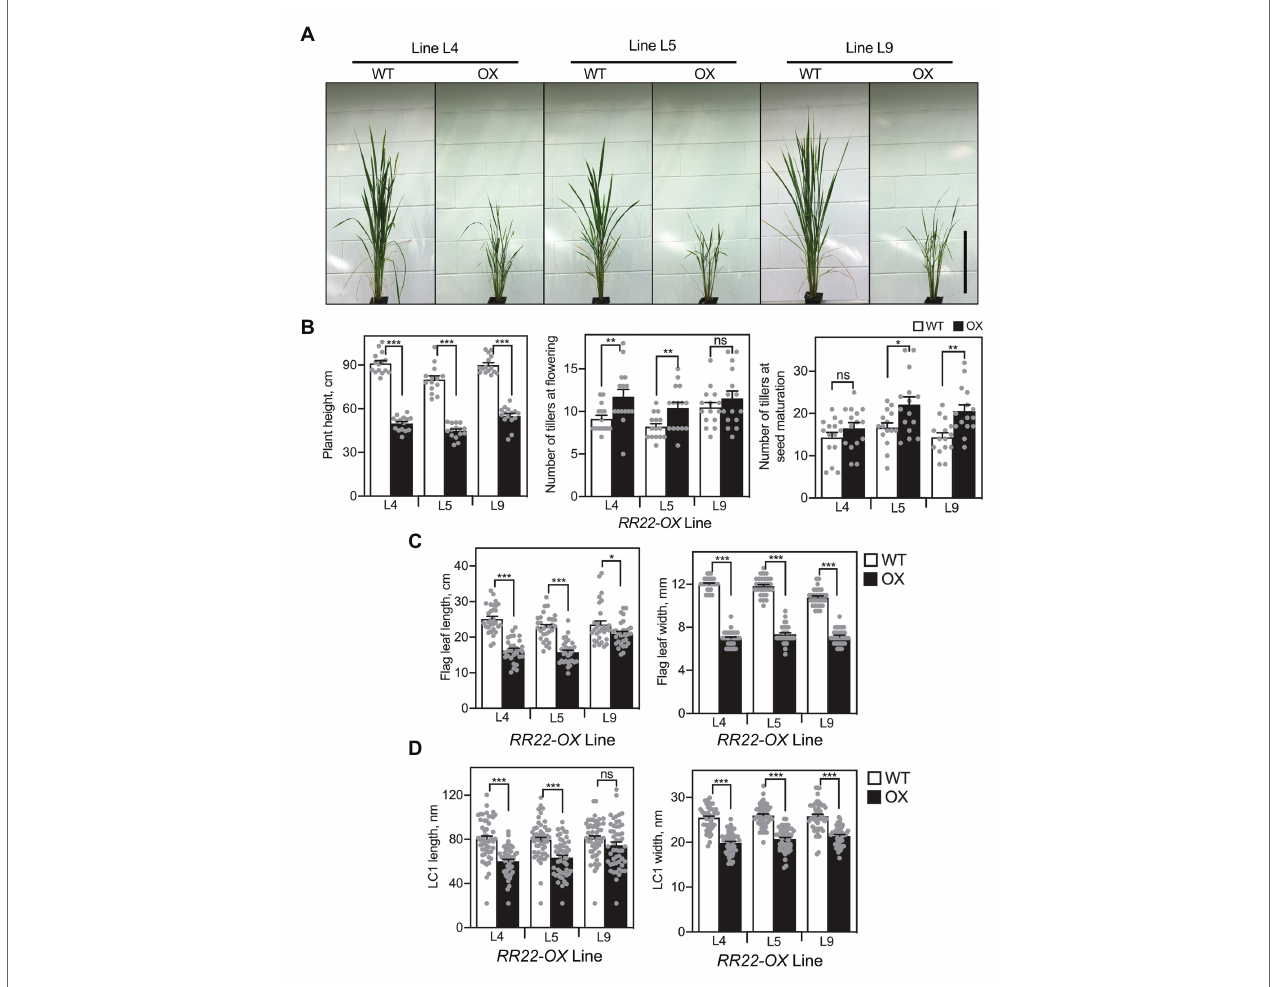
FIGURE 3 | Shoot growth phenotypes of RR22-OX lines. (A) Shoots of RR22-OX lines and their WT siblings, taken at the initiation of flowering in the WT plants. Scale bar = 30 cm. (B) Plant height at flowering, number of tillers at flowering and at seed maturation. (C) Flag leaf length and width. (D) Epidermal long cell 1 (LC1) length and width of the flag leaves. Error bars show SE. The T -test was used for statistical comparison of each RR22-OX line to its WT sibling (* p < 0.05; ** p < 0.01; *** p < 0.001; ns, not